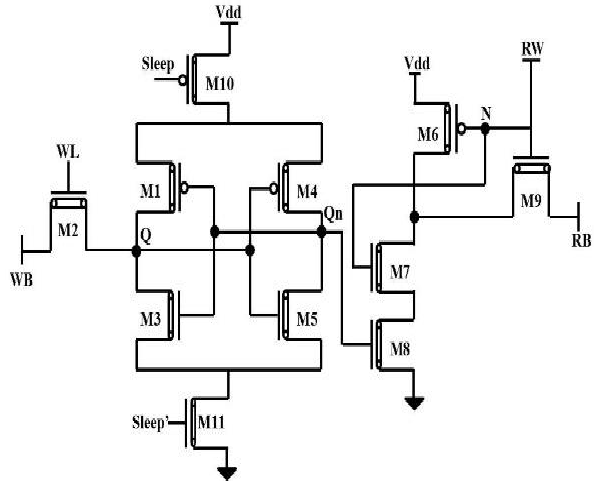
Figure 10. CNFET - Multi - Threshold 9T - SRAM cell.